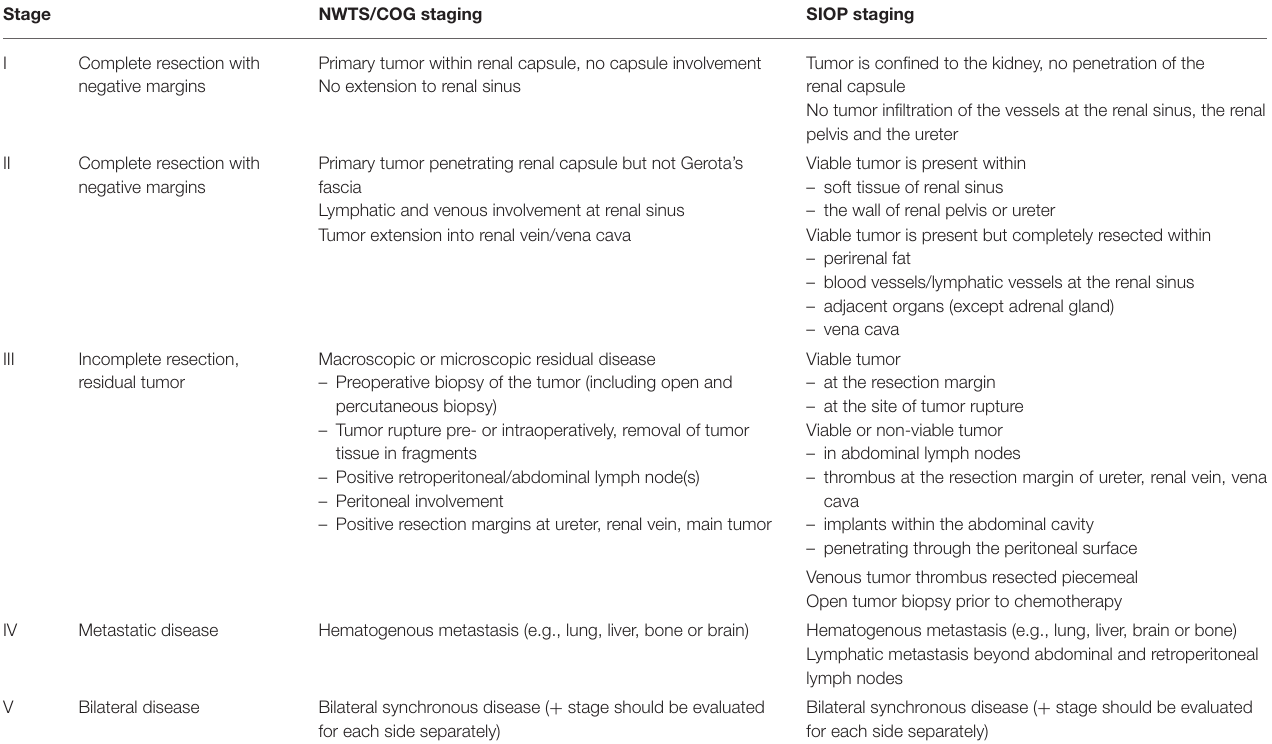
TABLE 1 | Current staging systems of WT according to NWTS/COG and SIOP (post-surgery).